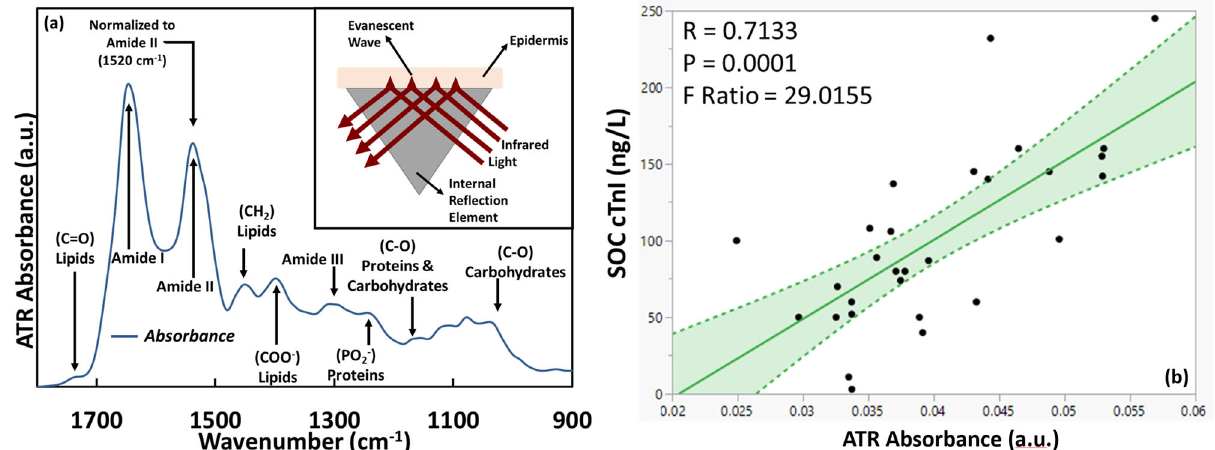
Fig. 2 Ex vivo exploratory research. Attenuated Total Re fl ectance (ATR) absorbance spectrum of epidermis indicating the characteristic peaks representative of the individual molecular components. Inset in ( a ) indicates the working principle of ATR. 1 ( b ) A linear correlation of 71% was observed between the high sensitivity cTnI assay-derived data and the optical device absorbance ( n = 30) performed on whole blood (ex vivo). The shaded region indicates the 95% con fi dence interval. (BNP = Brain Natriuretic Peptide, LAD = Left Anterior Descending, LCX = Left Circum fl ex, CAG = Coronary